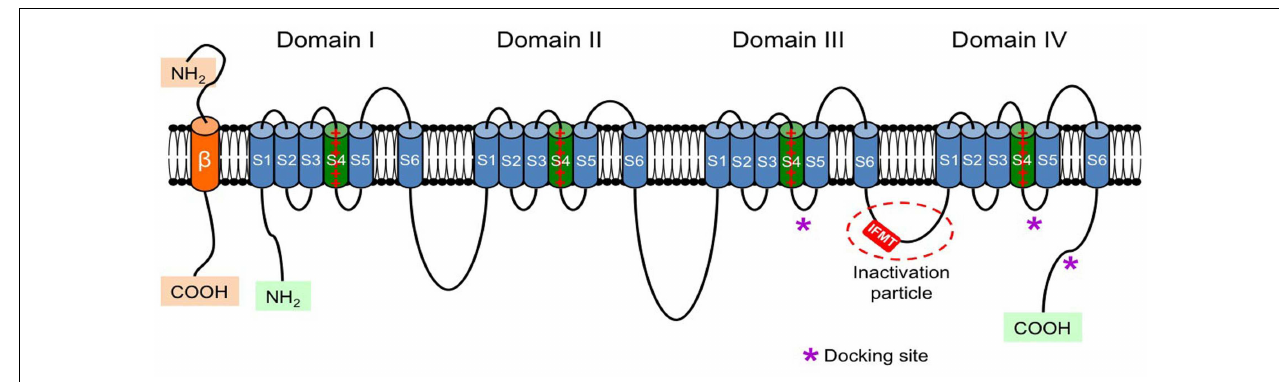
substitution of aminoacids in this region can disrupt the inactivation process of the channel.The “docking site” consists of multiple regions that include the cytoplasmic linker between S4–S5 in domains III and IV, and the cytoplasmic end of the S6 segment in domain IV (*). Depending on the subtype of β -subunit considered they could interact (covalently or non-covalently) with the α